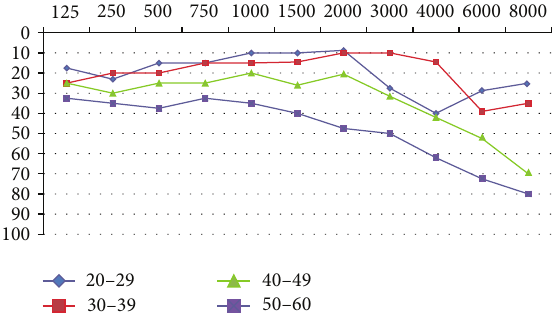
Figure 1: Hearing threshold with pure tone audiometry according